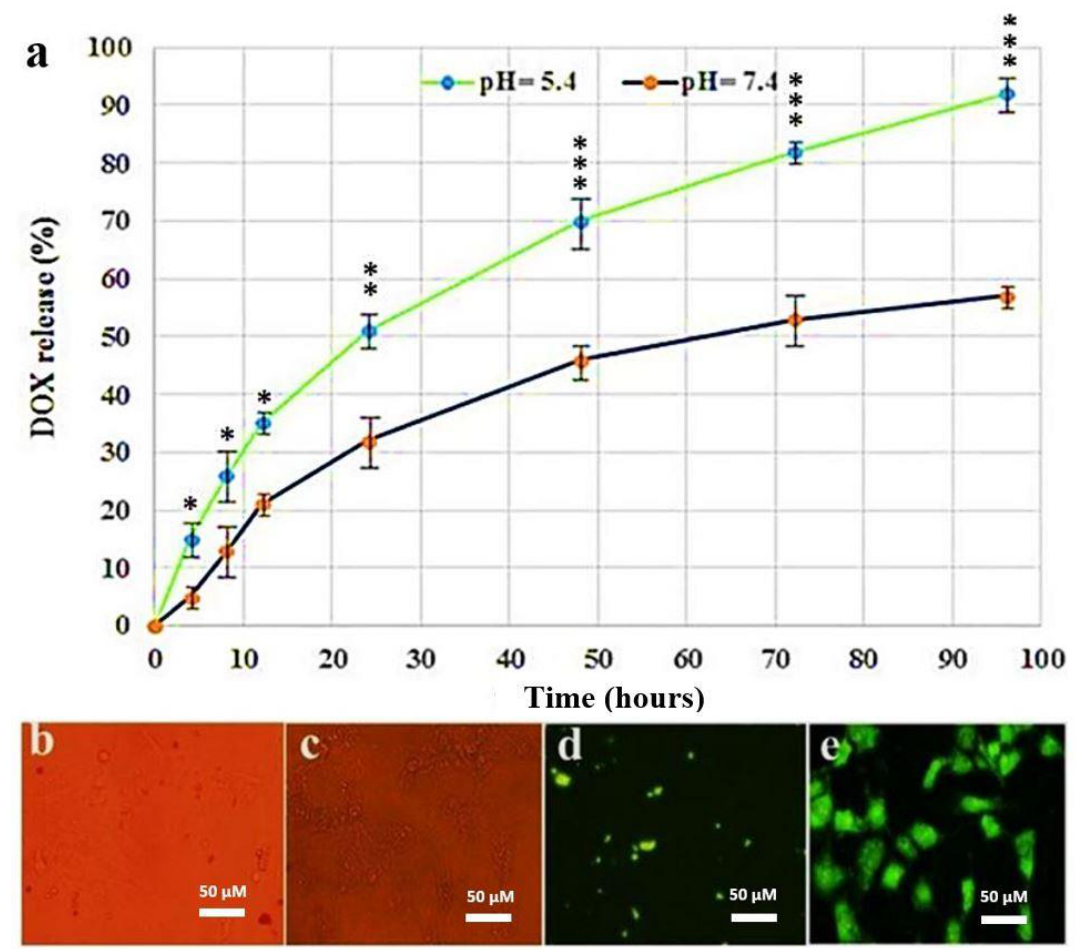
Figure 3. In vitro release profile of DOX from SPION@Au-CS-FA NPs at different pH values and the intracellular uptake. ( a ) the release rate of SPION@Au-CS-DOX-FA NPs at pH 7.4 and pH 5.4. All experiments were performed at 37 °C. The data represent mean ± S.D., (* p < 0.05; ** p < 0.01; *** p < 0.001); n = 3). ( b ) optical microscopy image of SPION@Au-CS-DOX-FA treated cells. ( c ) Optical microscopy image of free DOX. ( d ) fluorescence microscopy image of SPION@Au-CS-DOX-FA treated cells. ( e ) fluorescence microscopy image of free DOX.